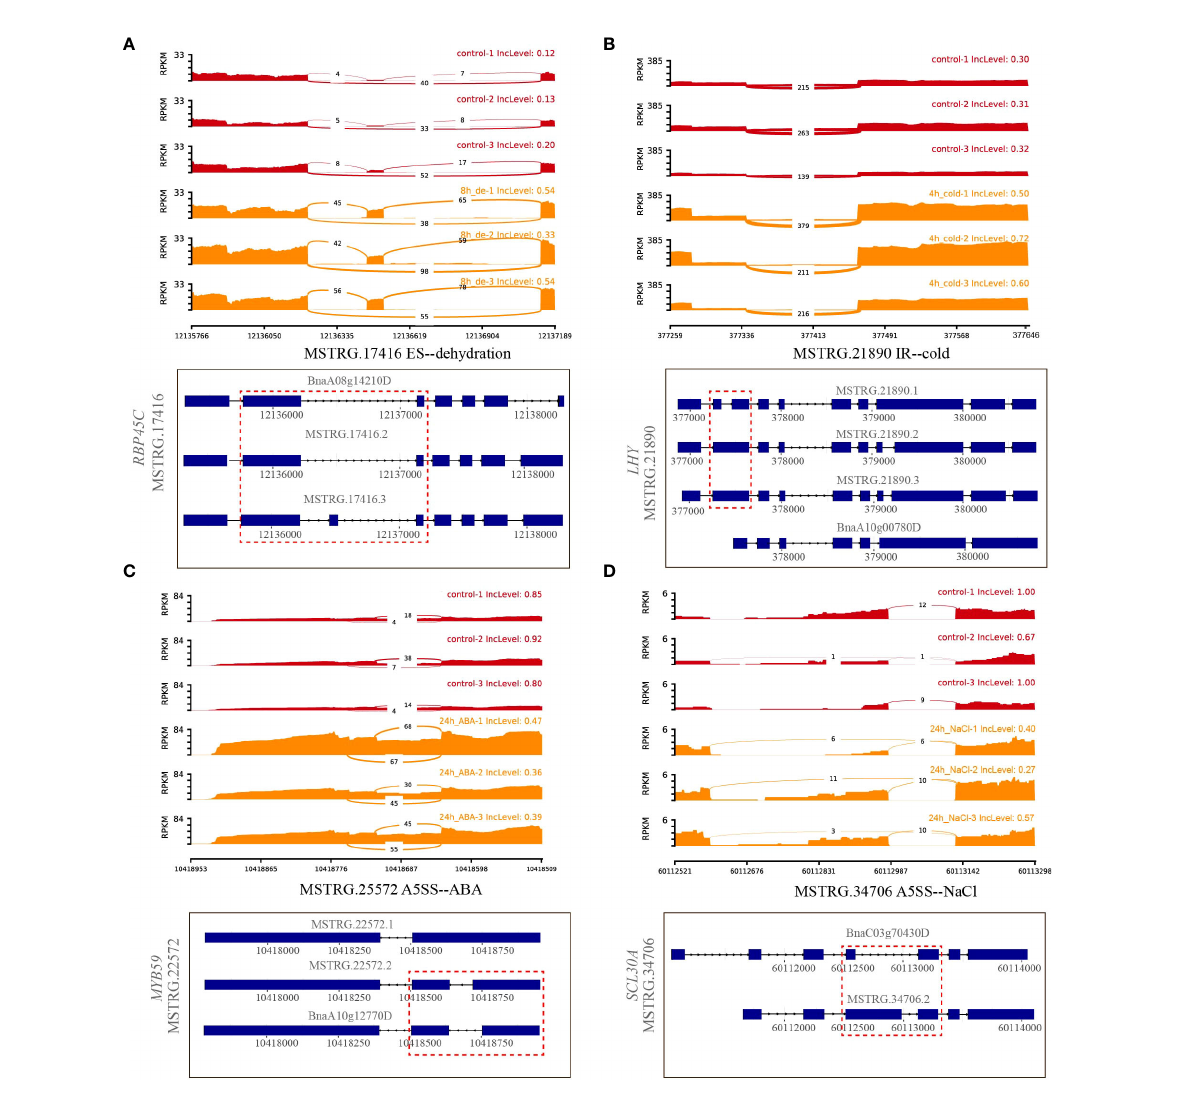
FIGURE 5 Quantitative visualization (sashimiplot) and transcripts structures of DAS genes under single abiotic stress. Panels (A – D) represented differential alternative splicing of different genes under dehydration, cold, ABA, and salt stress, respectively. Red dashed box indicated exons and introns showed in sashimiplots corresponding to gene structures below. The IncLevel value represented the normalized proportion of AS event. The red color denote control, and orange color denote treatments. The blue rectangular boxes denote the exons, the lines denote the introns, and the arrows denote the transcriptional